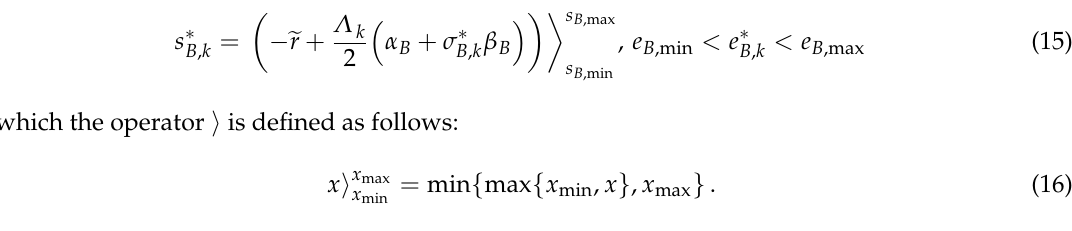
Figure 2. T he overall block control scheme of the proposed OPEM.